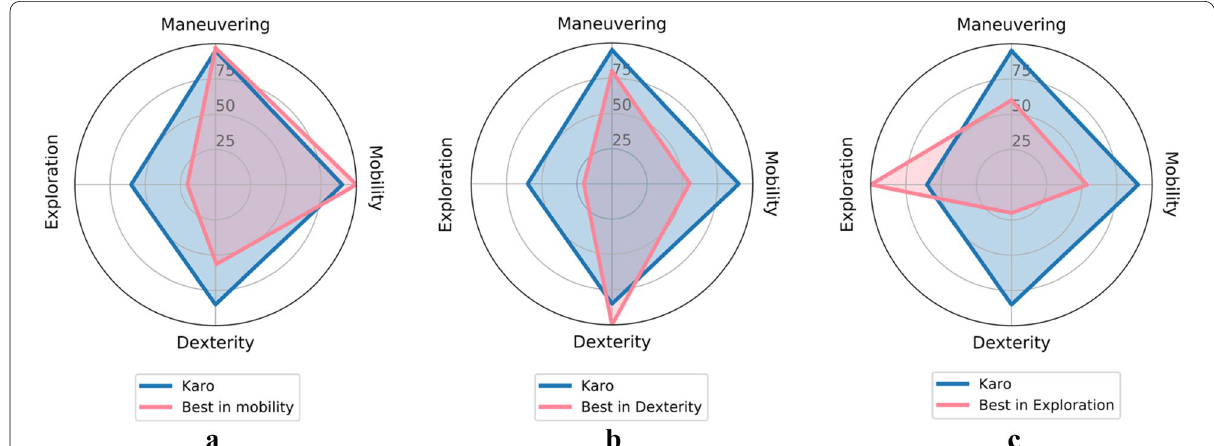
Fig. 26 Comparing Karo’s overall performance with the RRL winners of Mobility, Dexterity, and Exploration test suites (based on the results from RRL 2016).